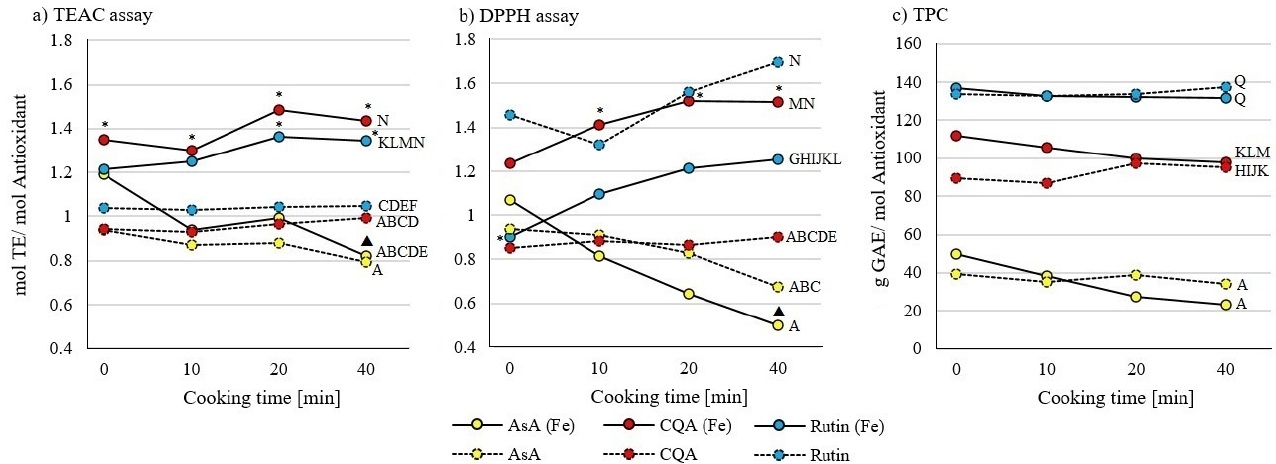
Figure 1. Influence of cooking time (0, 10, 20, and 40 min) on ascorbic acid (AsA; yellow), 5-caffeoylquinic acid (CQA; red), quercetin-3-rutinoside (Rutin; blue) with (solid lines) and without (dashed lines) iron (Fe) on antioxidant activity (AOA); standard deviation not shown. All samples were tested using ( a ) TEAC, ( b ) DPPH, and ( c ) TPC assays. Significant differences ( p ≤ 0.05 by Tukey’s HSD test ( n = 3)) with different cooking times of the same substance and between samples with and without iron are marked with an asterisk *. Differences to 0 min cooked samples of the same substance are marked with a triangle ▲ . Letters indicate differences between the three substances as mean values over all measured times and are comparable to results of the same test assay in Figures 2 and 3.